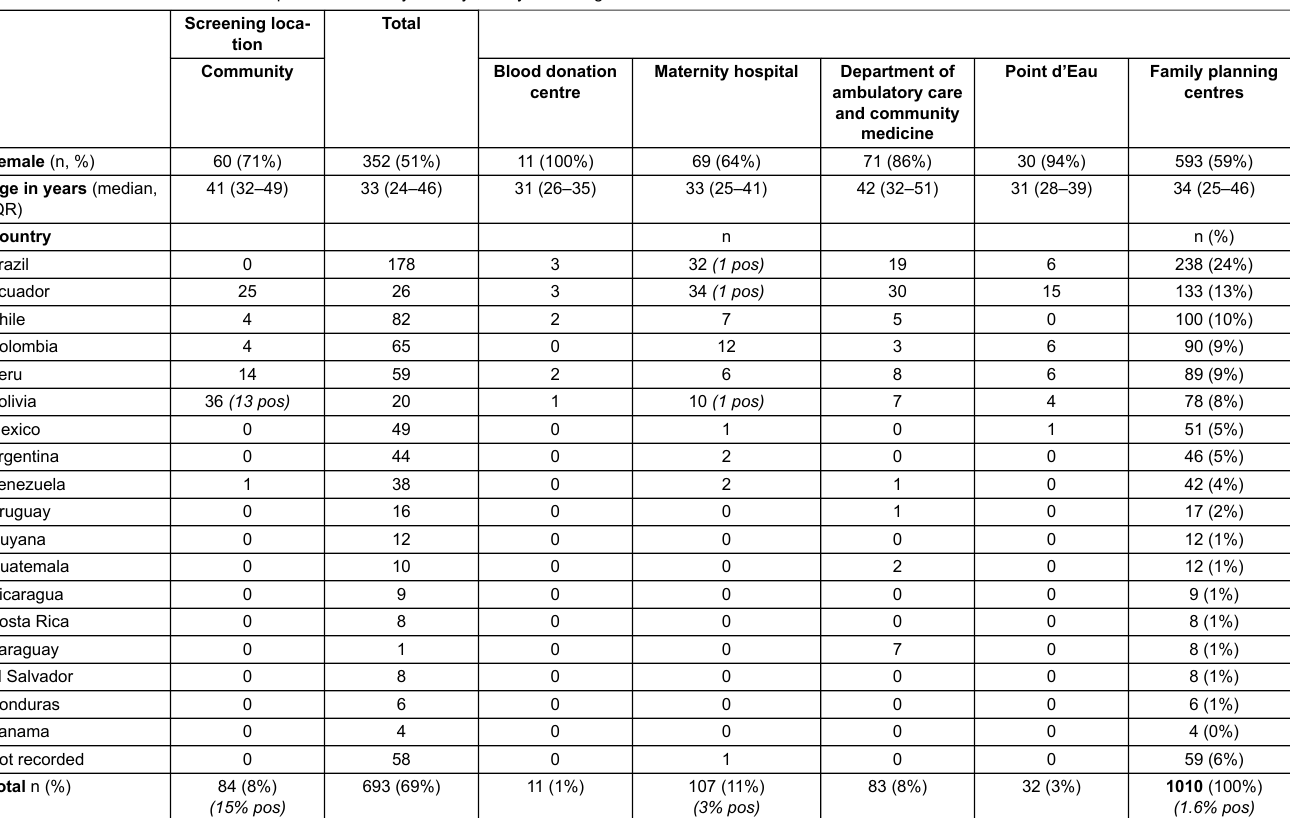
Table 1: Number and characteristics of persons tested by country and by screening location. Screening loca-